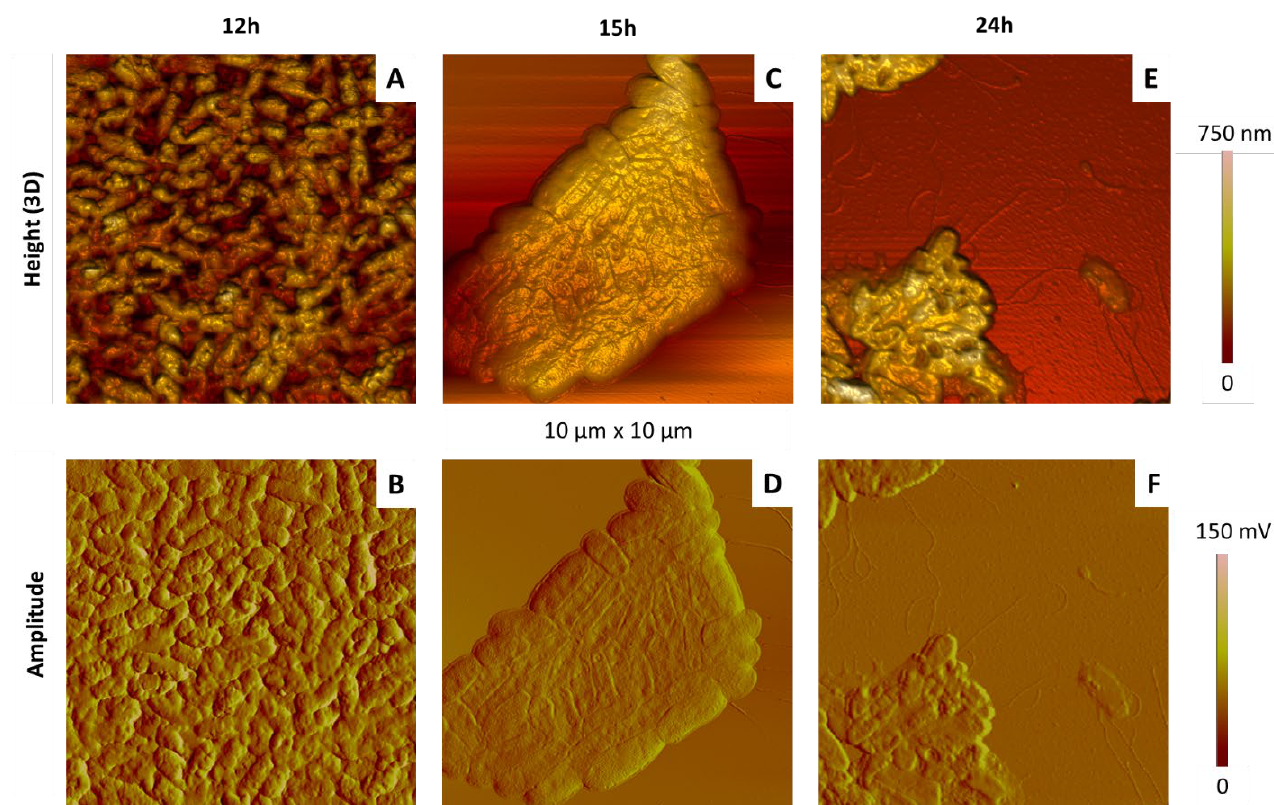
Figure 11. Effect of the incubation time on the morphology of aggregated P. fluorescens bacteria deposited by simple deposition. The bacteria were cultured in LB medium at 28 °C during different culture times: 12 h ( A , B ), 15h ( C , D ) and 24 h ( E , F ). AFM images are 3D height or topographic ones ( A , C , E ) and amplitude ones ( B , D , F ).